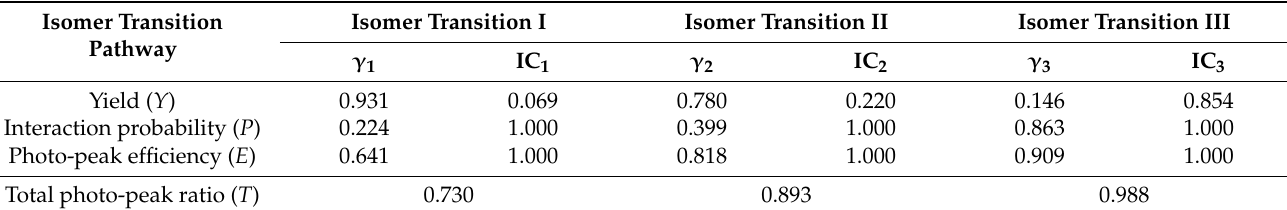
Table 3. Total photo-peak ratio by isomer transitions.